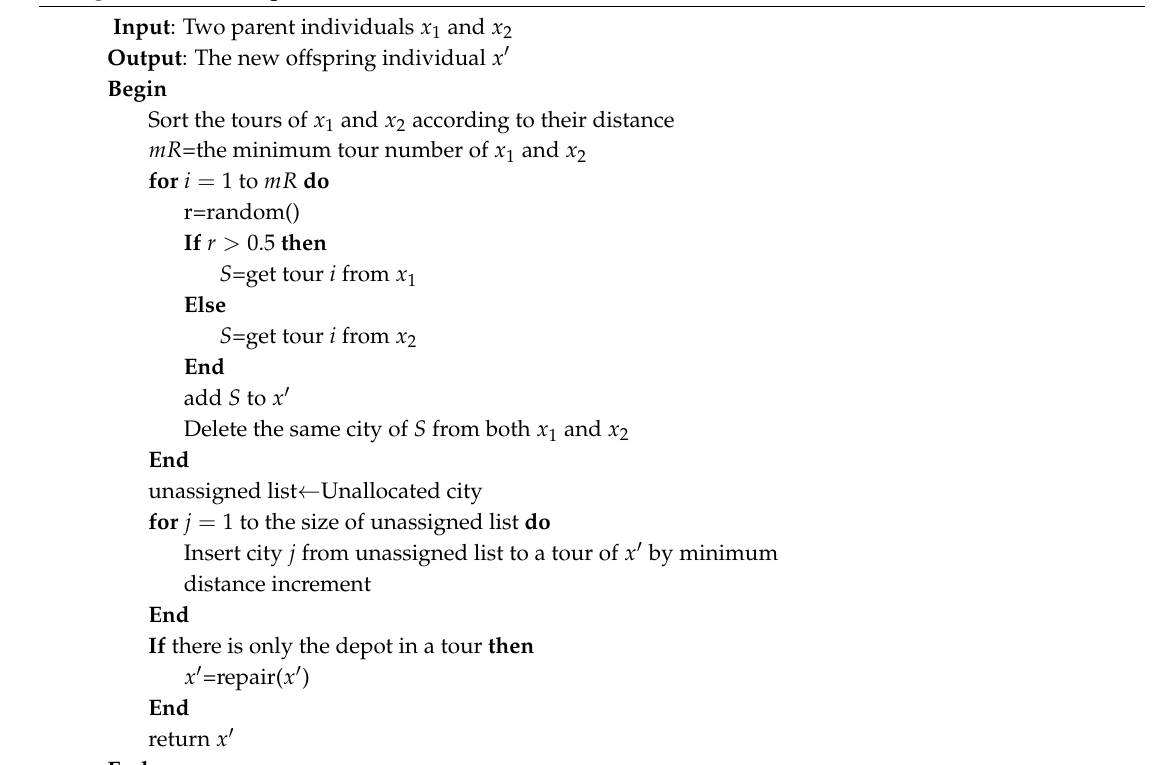
Algorithm 5: The pseudo-code of